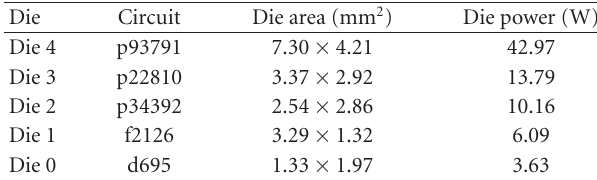
Table 2: The second test case.